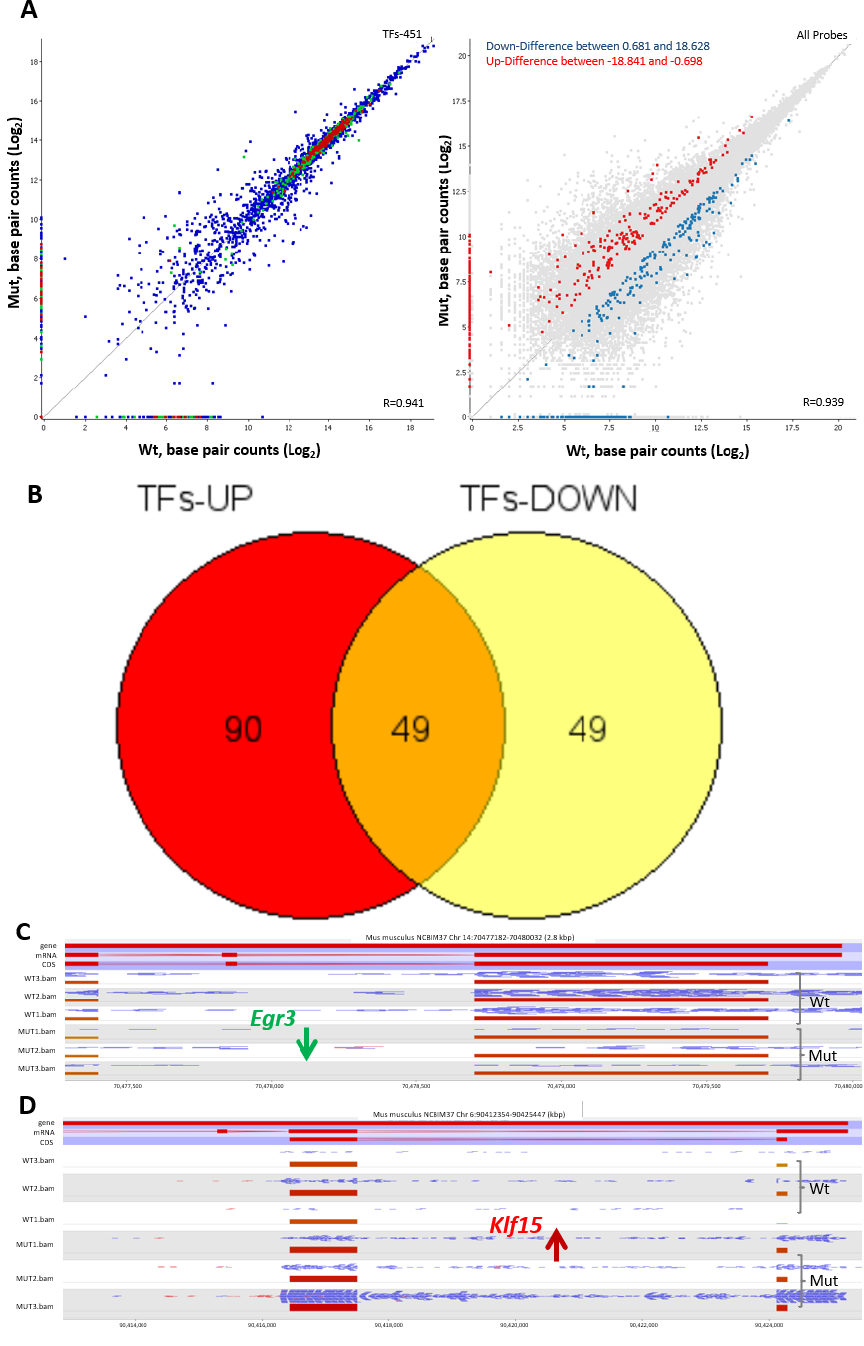
Figure 5. Transcription factors (TFs) affected by the loss of TSPO. ( A ). A scatter plot of a total of 451 mouse TFs from HOmo sapiens COmprehensive MOdel COllection (HOCOMOCO; http://hocomoco11.autosome.ru) between Wt vs. Tspo Mut (left) and their highlighted distribution in the total transcriptome changes (right). The color of the dots in the left panel represent TFs showing higher expression (red), reduced expression (green) and no change in expression levels (blue) between Wt and Mut cells. ( B ). 90 TFs are up-regulated and 49 TFs are down-regulated from a total of 188 TFs dramatically changed by the loss of TSPO. C-D. An example of down- ( C ) and up ( D ) regulated genes: Egr3 (early growth response 3) and Klf15 (Kruppel like factor 15), are presented. Egr3 is an immediate-early growth response gene, which is induced by mitogenic stimulation, whereas Klf15 is a negative regulator of TP53 acetylation that inhibits NF- κ B activation through repression of EP300-dependent RELA